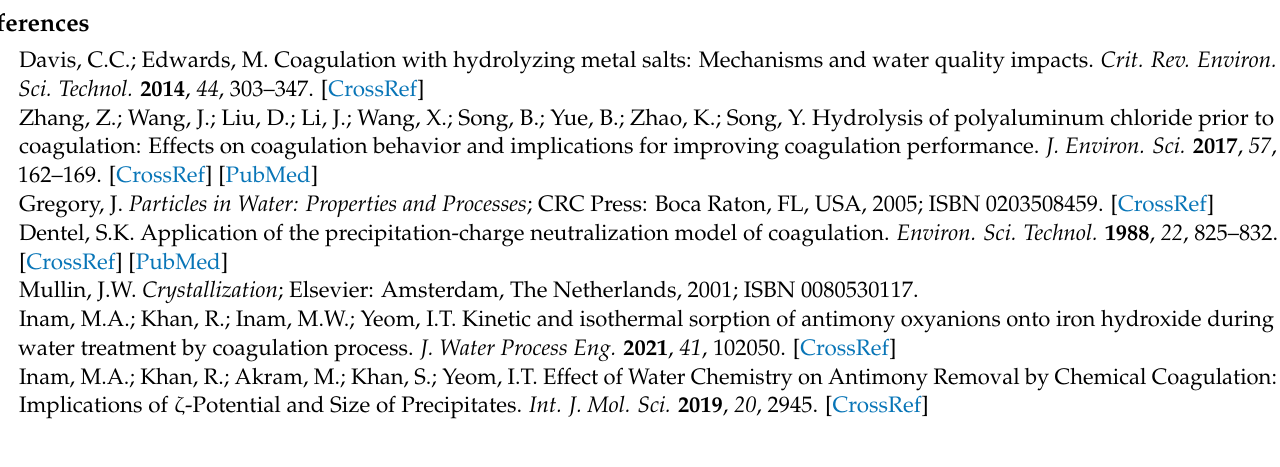
Figure S4: Influence of PO 43 − concentration on (A) zeta potential (mV) and size (nm) of freshly formed Fe flocs and; (B) PO 43 − removal (%) in pure water, Figure S5: Influence of HA concentration on (A) zeta potential (mV) and size (nm) of freshly formed Fe flocs and; (B) TOC removal (%) in pure water, Figure S6: Influence of SA concentration on (A) zeta potential (mV) and size (nm) of freshly formed Fe flocs and; (B) TOC removal (%) in pure